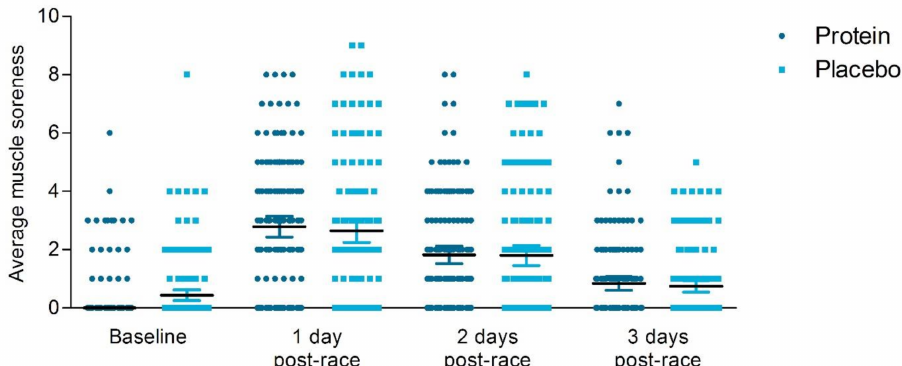
Figure 3. Ratings of perceived lower extremity muscle soreness of the past 24 h (Numeric Pain Rating Scale). The ratings are shown from baseline, 1 day post-race, 2 days post-race and 3 days post-race for the protein group ( • dark blue circles) and the placebo group ( (cid:4) light blue squares) with the median and interquartile range (IQR), based on intention-to-treat analysis. The protein group reported similar ratings of perceived lower extremity muscle soreness at 1–3 day post-race compared to the placebo group ( p >